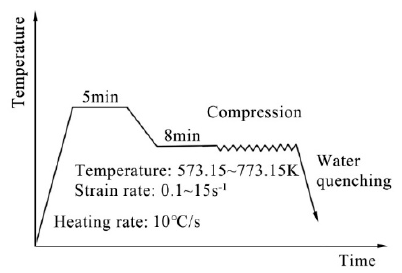
Figure 1. Specimens and test equipment: ( a ) size of test specimens (unit: mm); ( b ) loading equipment.